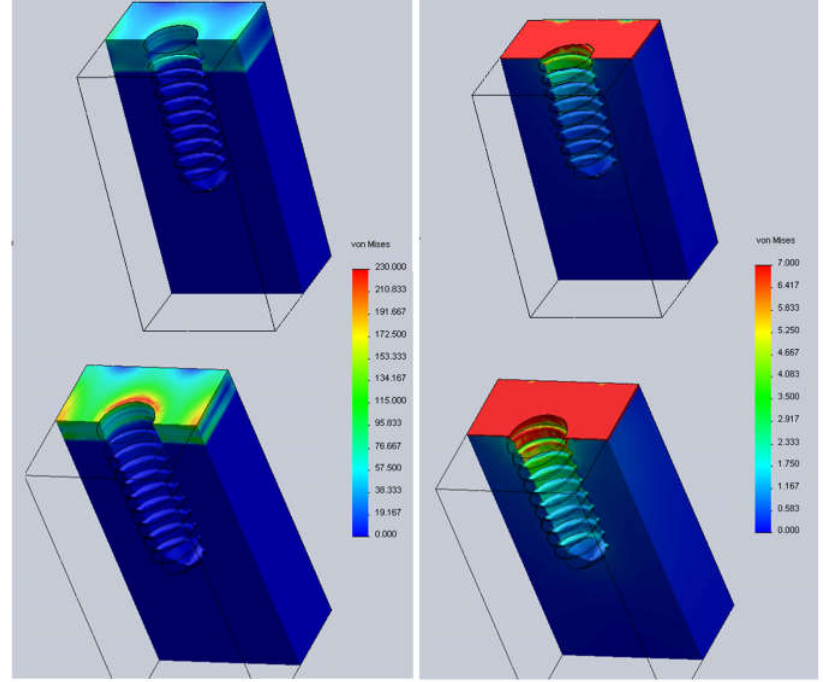
Figure 3. Von Mises stresses (MPa). Left column: cortical bone. Right column: trabecular bone. Top row: cortical thickness 2.5 mm. Bottom row: cortical thickness 1.5 mm.